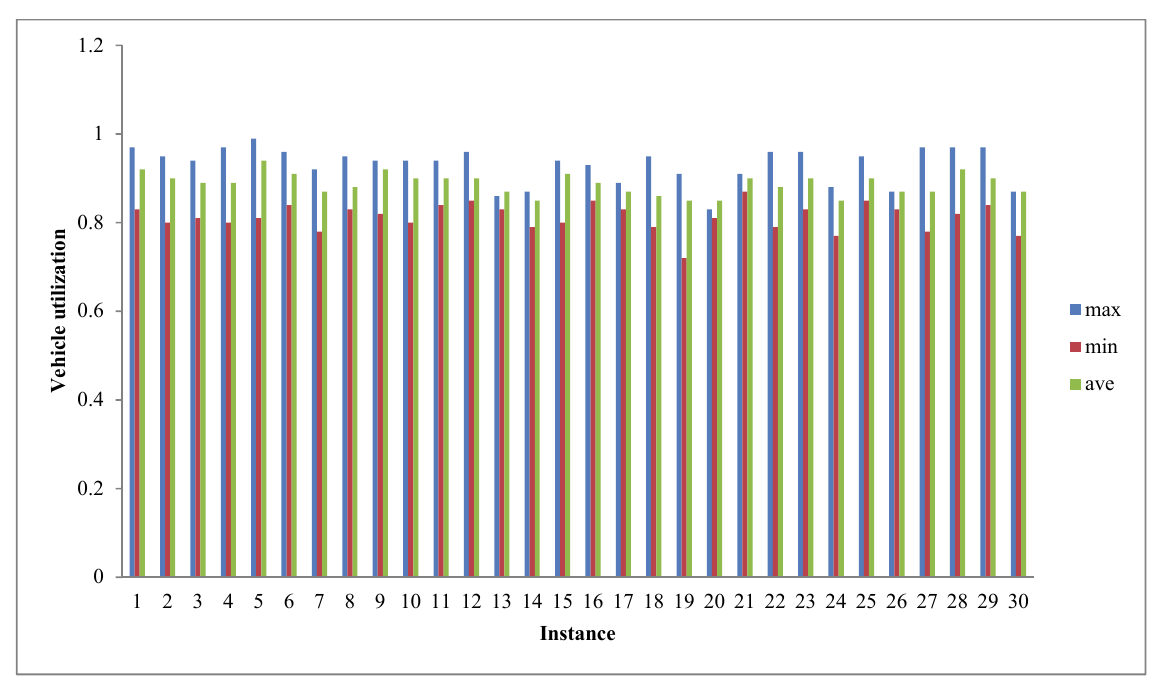
Fig. 4. The using rate of vehicles’